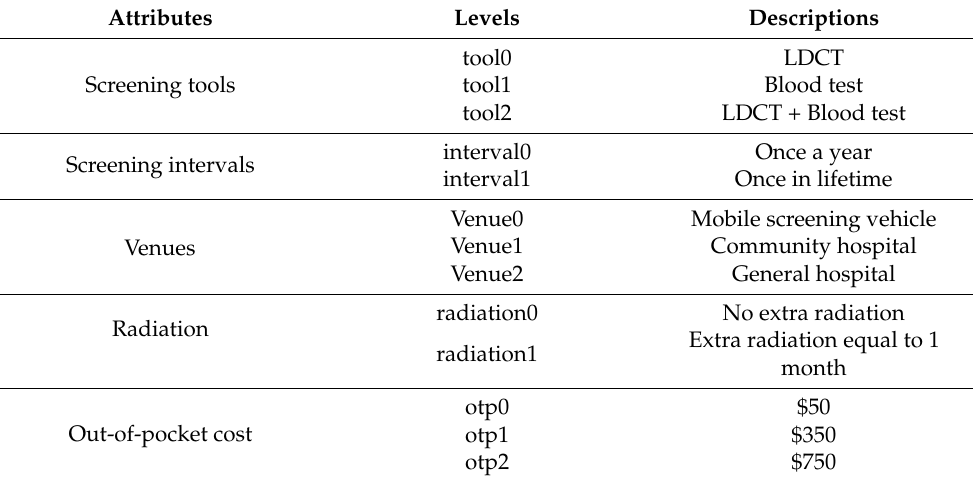
Table 1. Included attributes and